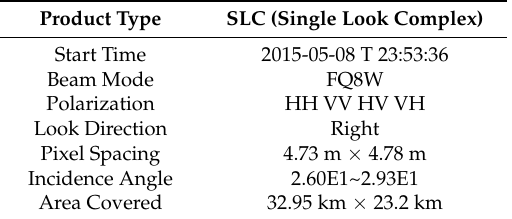
Table 2. Information on the image of RadarSAT-2 used in this study (Dataset 1).